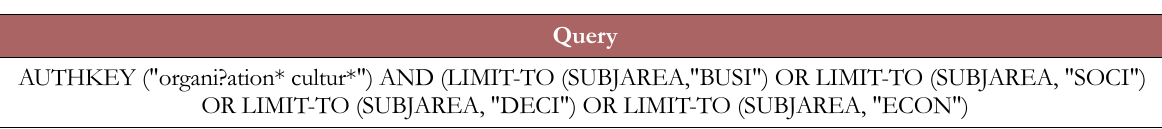
Table 1. Query terminology adapted to the Scopus database